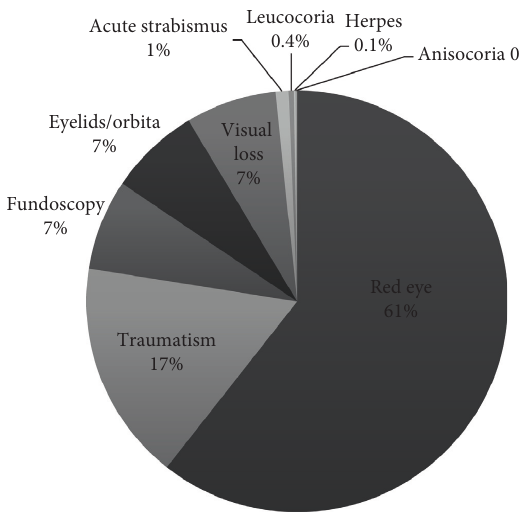
Figure 1: Reasons for